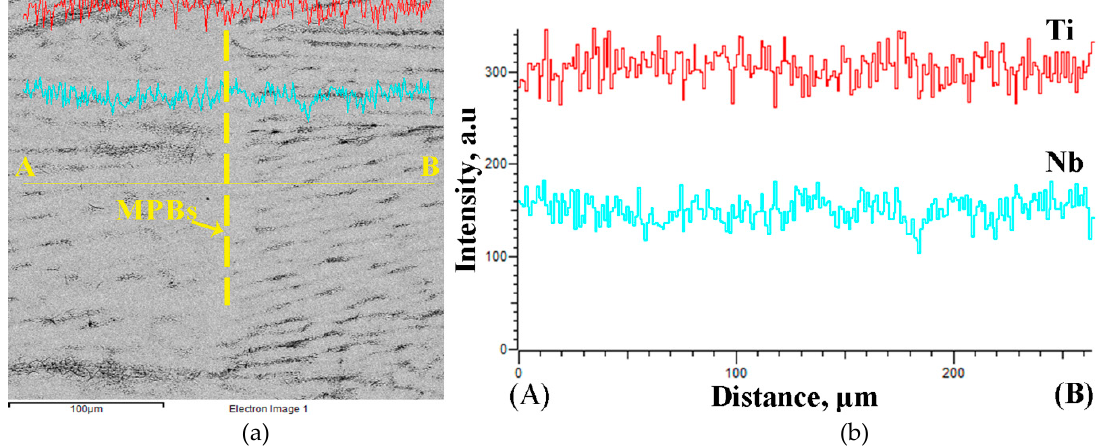
Figure 6. ( a ) Energy-dispersive X-ray spectroscopy (EDS) line scanning of melt pool in lateral plane of Ti–26Nb alloy ( b ) corresponding line scanning results of Ti and Nb elements.